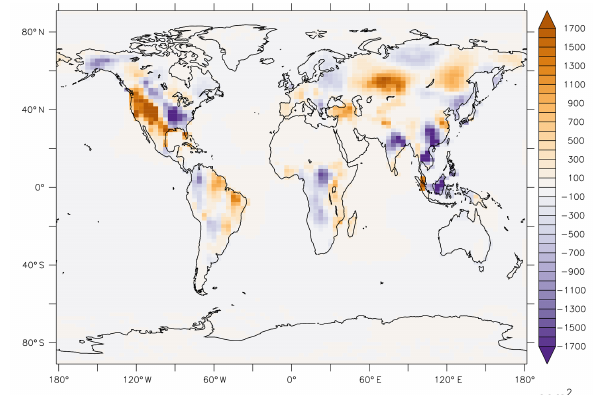
Figure 10. Contribution of the grid-point flux changes to the change in the variance of CO 2 model–measurement differences between the OCO-2-based inversion and the surface-based inversion (vari- ance of the former minus variance of the latter), in parts per million squared. Both inversions use LMDz5A. Note that the fluxes them- selves are illustrated in Fig. 6a and